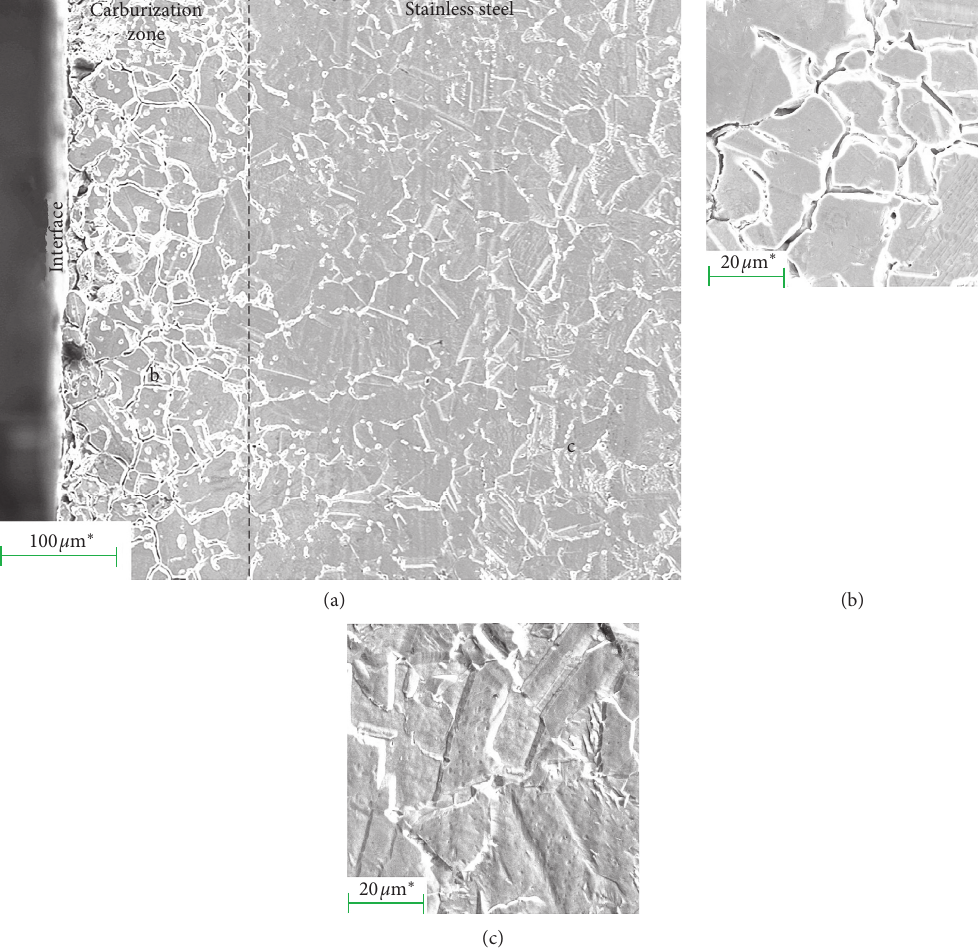
Figure 6: The microstructure in the thickness direction of stainless steel (cladding) in the bimetal plate: (a) macropicture and (b) and (c) micropicture.